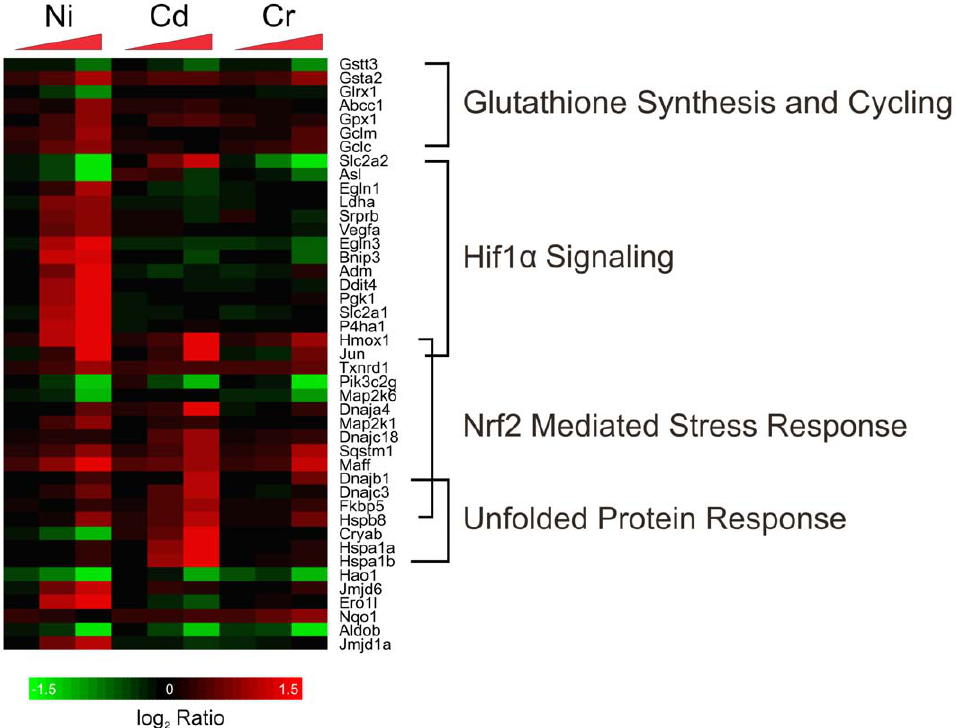
Figure 5. Expression Patterns of genes involved in the response to oxidative stress. The expression patterns of 43 genes that are involved in the oxidative stress response are depicted. While all three metals share the common overall mechanism and show a Nrf2 mediated stress response, nickel-induced genes involved in glutathione synthesis, and cadmium induced those that may be responding to ER stress. The triangles indicate increasing concentrations of metals and the color indicates the log 2 ratio of control to experimental expression